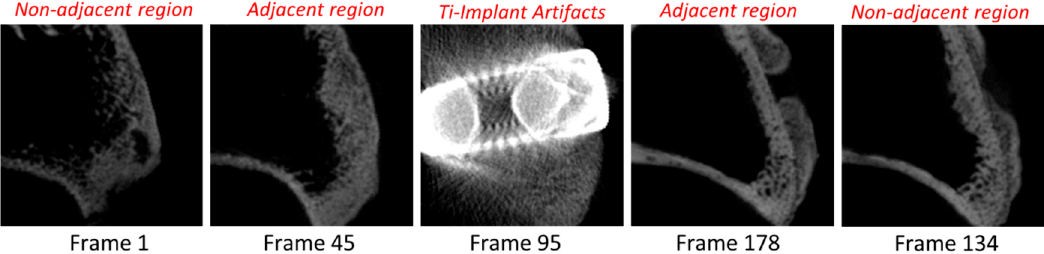
Figure 18. Radiological analysis by CT imaging following implantation. The strong artefacts along the screw axis made it impossible to analyze bone structures in these positions (i.e., frame 95). To avoid biases due to this issue, results were calculated as the difference between the values obtained in non-adjacent regions (i.e., frame 1) and the adjacent regions (i.e., frame 45). Table 5. Bone structure analysis data obtained with the Imaris ® software.